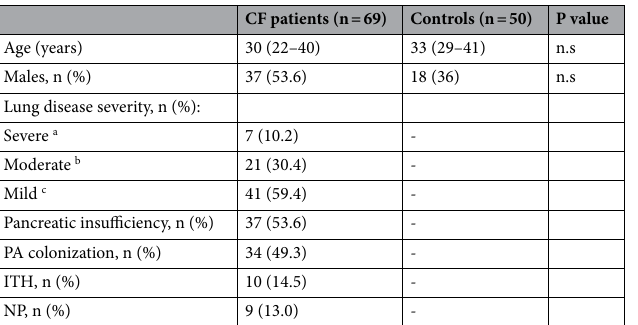
Table 1. Demographic and clinical parameters of patients with cystic fibrosis (CF) and healthy subjects (controls). a FEV1 < 40%; b FEV1 40–69%; c FEV1 > 69%. ITH: inferior turbinate hypertrophy; NP: nasal polyposis; n.s.: not significant; PA: P.